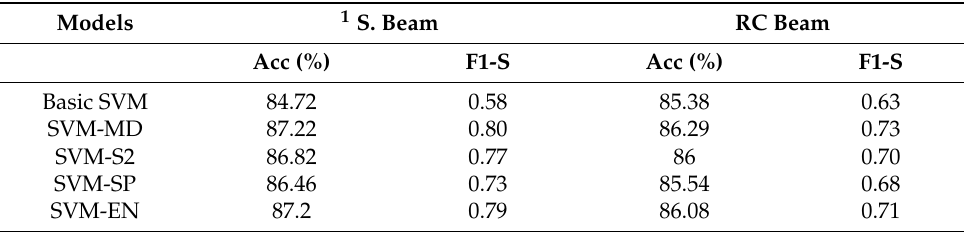
Table 6. Comparison of accuracy between basic SVM, SVM-MD, SVM-S2, SVM-SP, and SVM-EN for simple and RC beams.